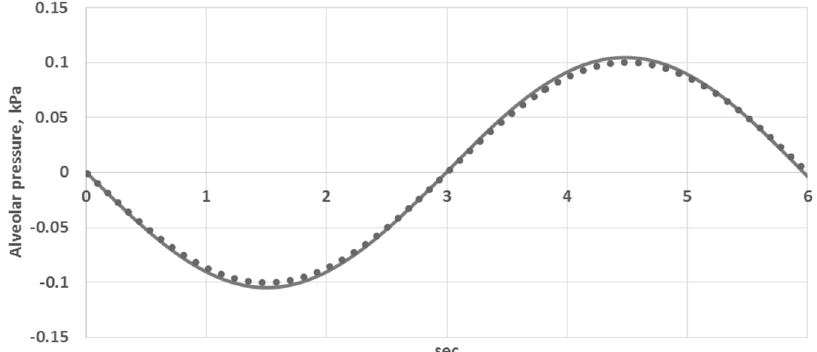
Figure 3. Comparison of the calculated and measured alveolar pressure (kPa): curve—the data from [29], dots—simulations.